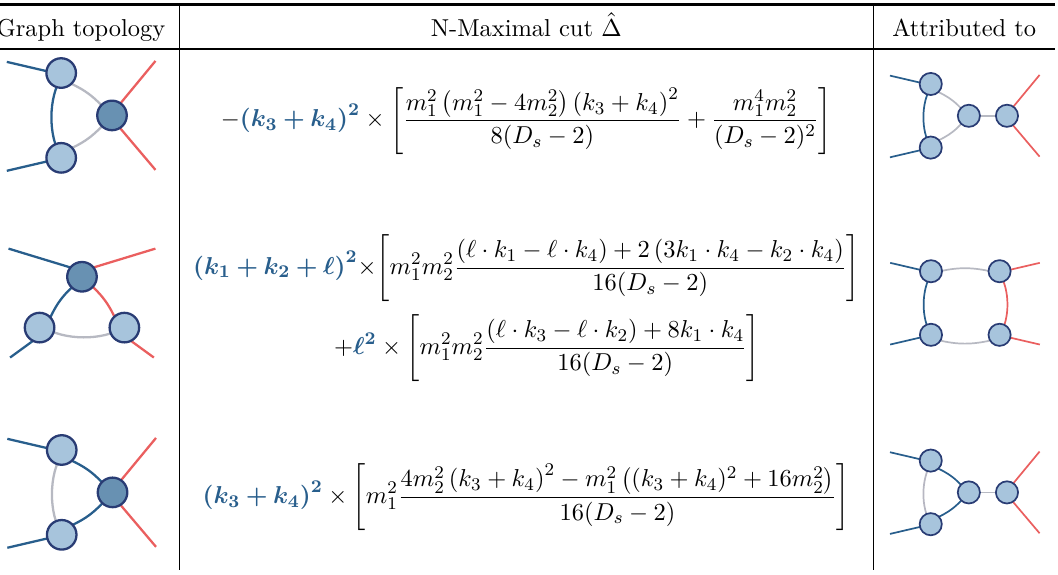
Figure 2 . Next-to-maximal cuts of the one-loop four-point amplitude. Light blue blobs represent three-point amplitudes, dark blobs represent four-point amplitudes, and exposed legs represent on- shell propagators.